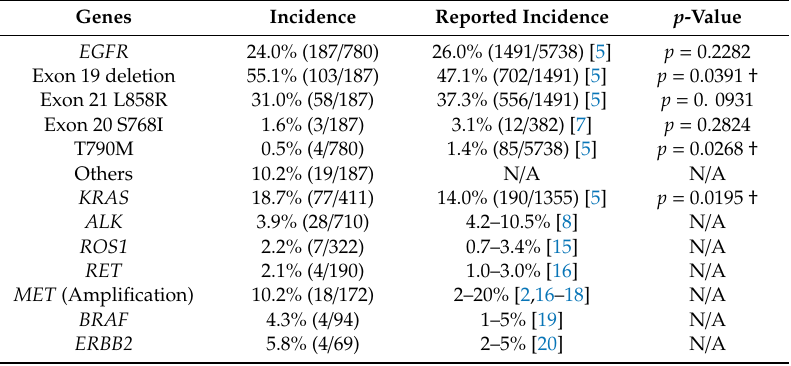
Table 2. Alteration incidences of the driver